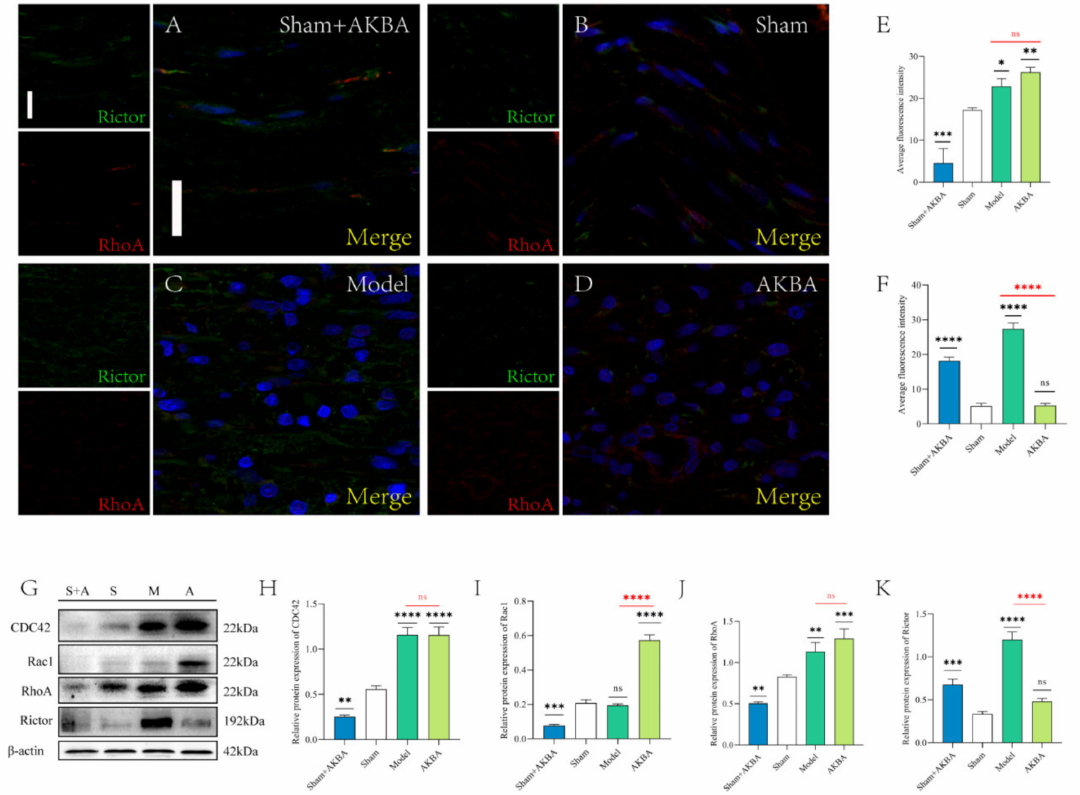
Figure 4. Protein changes in the injured sciatic nerve after 5 d of AKBA intervention. ( A – D ) Immunofluorescence staining plots of RhoA and Rictor for each group. The scale bar of